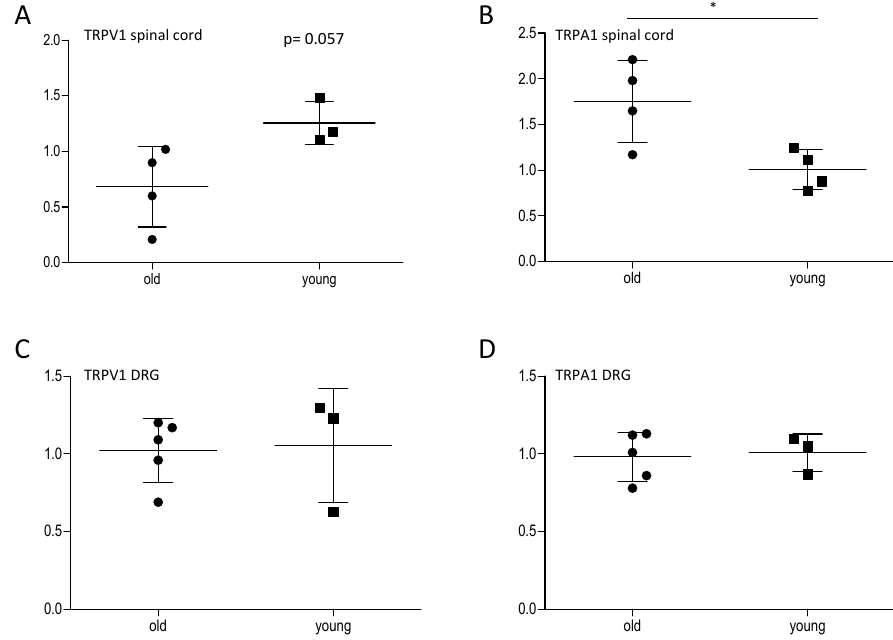
Figure 3. Effect of age on TRPV1 and TRPA1 expression in the spinal cord and the DRGs. TRPV1 and TRPA1 mRNA expression in the spinal cord ( A , B ) and the DRGs ( C , D ) of young and old mice 45 min after formalin injection into the hind paw, analyzed by qRT-PCR ( n = 3–5/group), * p < 0.05, statistically significant difference between the groups.